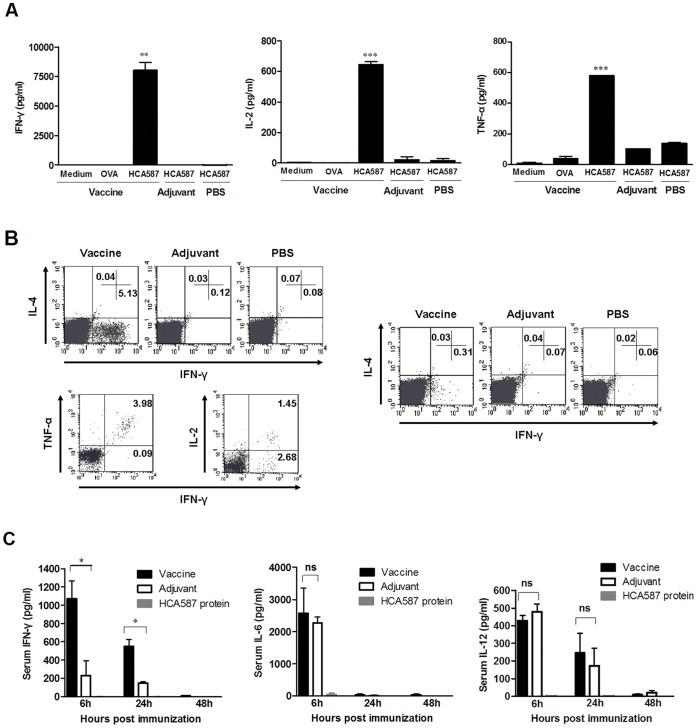
HCA587 protein vaccination triggers Th1-type responses.Mice (nine per group) were immunized with HCA587+ CpG + ISCOM, CpG + ISCOM, or PBS, and boosted 21 days later. (A) Splenocytes were harvested 14 days after the boost and cultured with medium alone, ovalbumin (OVA) or HCA587 protein for 24 h. Cytokine levels in the supernatants were determined using commercial ELISA kits for IFN-γ, IL-2, and TNF-α. ***, P<0.001; **, P<0.01, compared with other groups. (B) Splenocytes were stimulated with HCA587 protein for 24 h. Intracellular staining was performed for IFN-γ, IL-4, TNF-α and/or IL-2 following surface staining for CD4 and CD8. The experiments were performed at least 3 times with similar results. A representative profile of cytokines produced by CD4+ (Left) and CD8+ (Right) T cells is shown. (C) Serum cytokine levels. Sera were collected at 6, 24 and 48 h after the boost and analyzed for levels of IFN-γ, IL-6,and IL-12 using ELISA kits. Columns, mean values; bars, SE. *, P<0.05; ns, P > 0.05.